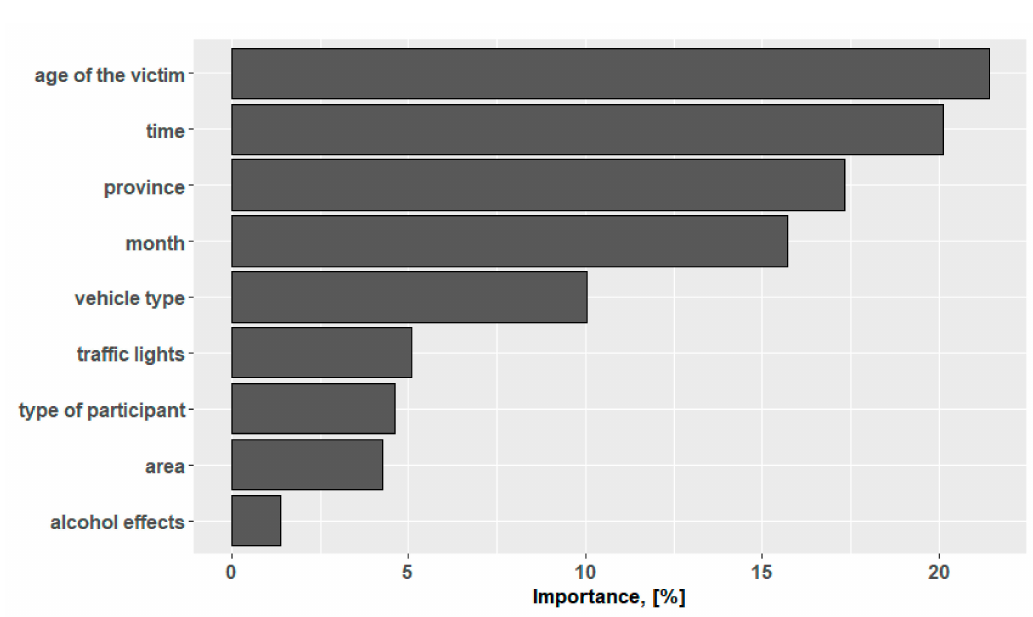
Figure 4. Predictor importance ranking for the random